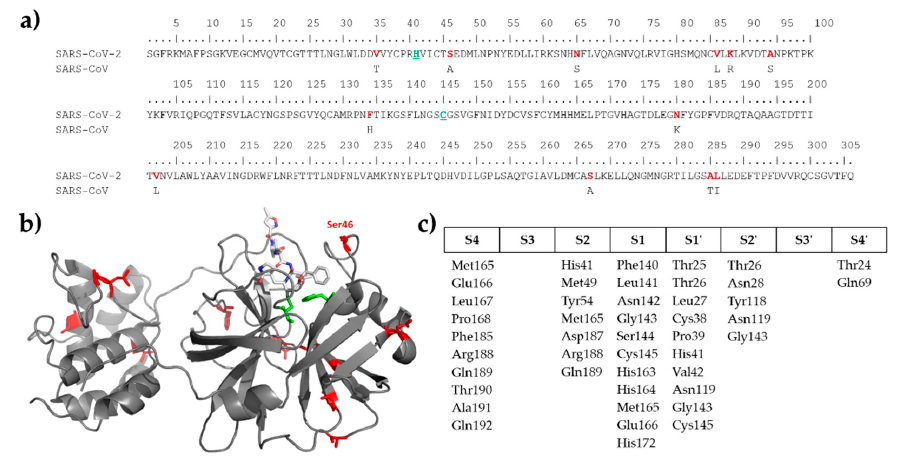
Figure 1. Comparison of SARS-CoV and SARS-CoV-2 3CL proteases. ( a ) Sequence alignment of the proteases is shown, only those residues are represented for SARS-CoV 3CLpro that are different as compared to SARS-CoV-2 3CLpro. Active site residues are green and underlined, residues that differ in the two proteases are red. ( b ) Schematic structure of SARS-CoV-2 3CLpro based on its X-ray crystal structure (6LU7.pdb). Catalytic residues (His41 and Cys145) are highlighted by green color, the residues that are different in SARS-CoV and SARS-CoV-2 3CL proteases are shown by red. Ser46 residue is also highlighted. Inhibitor bound to the active site is also shown by sticks. ( c ) Compositions of substrate binding subsites are shown based on literature data [11–13,16], subsite nomenclature is shown according to Schechter and Berger